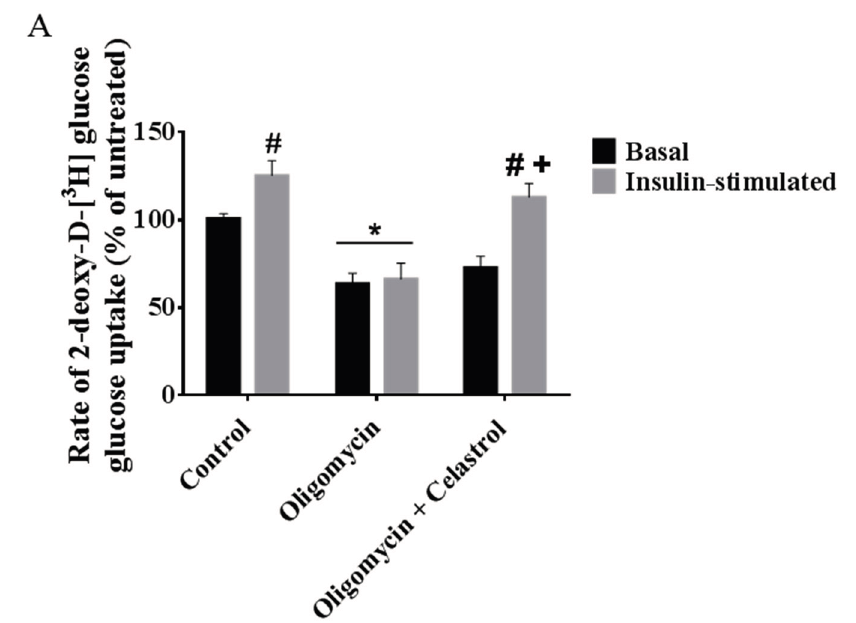
Figure 7. Effects of celastrol treatment on insulin signaling cascades and glucose transporter in differentiated 3T3-L1 adipocytes with mitochondrial dysfunction. Representative